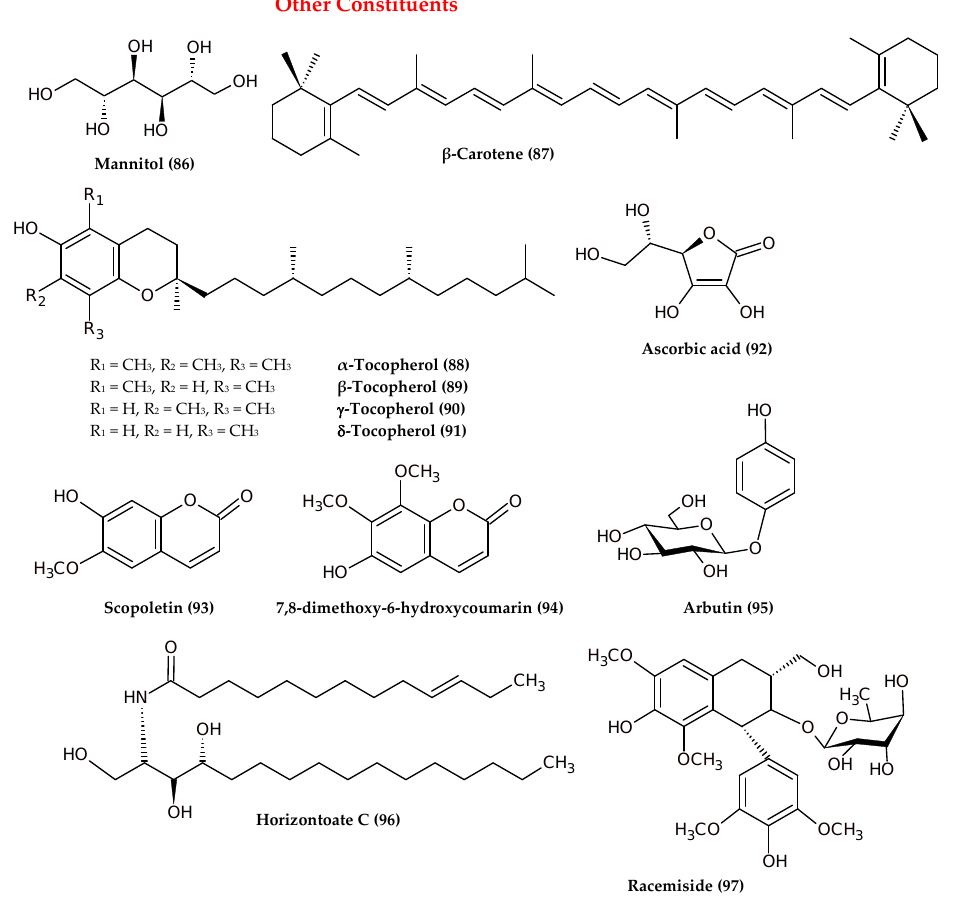
Figure 4. The chemical structures of the other compounds identified in the genus Cotoneaster .